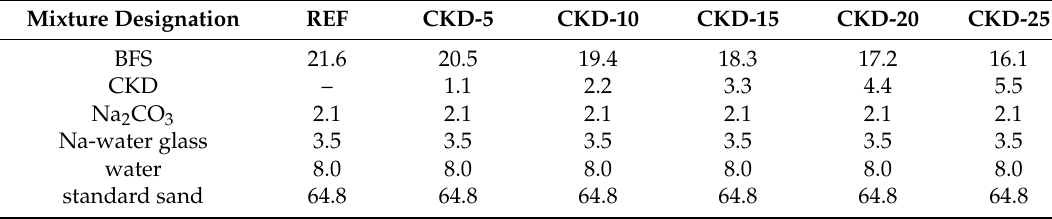
Table 2. Composition of alkali-activated mortar samples (wt